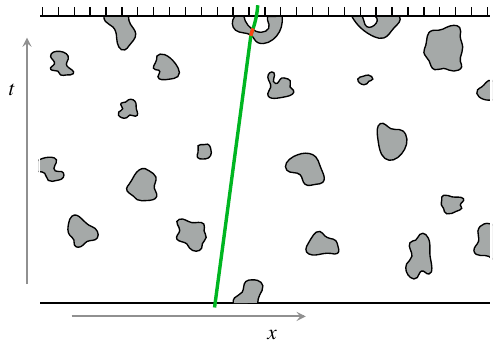
FIG. 7. Cartoon of the minimal cut in the disentangling phase for S 0 (cf. Fig. 6). The clusters of broken bonds now percolate, forming the infinite white region. The cost of the minimal cut remains finite as t → ∞ : Only a finite number of unbroken bonds need to be traversed to reach the infinite white cluster. Therefore, S 0 ð t Þ ∼ t 0